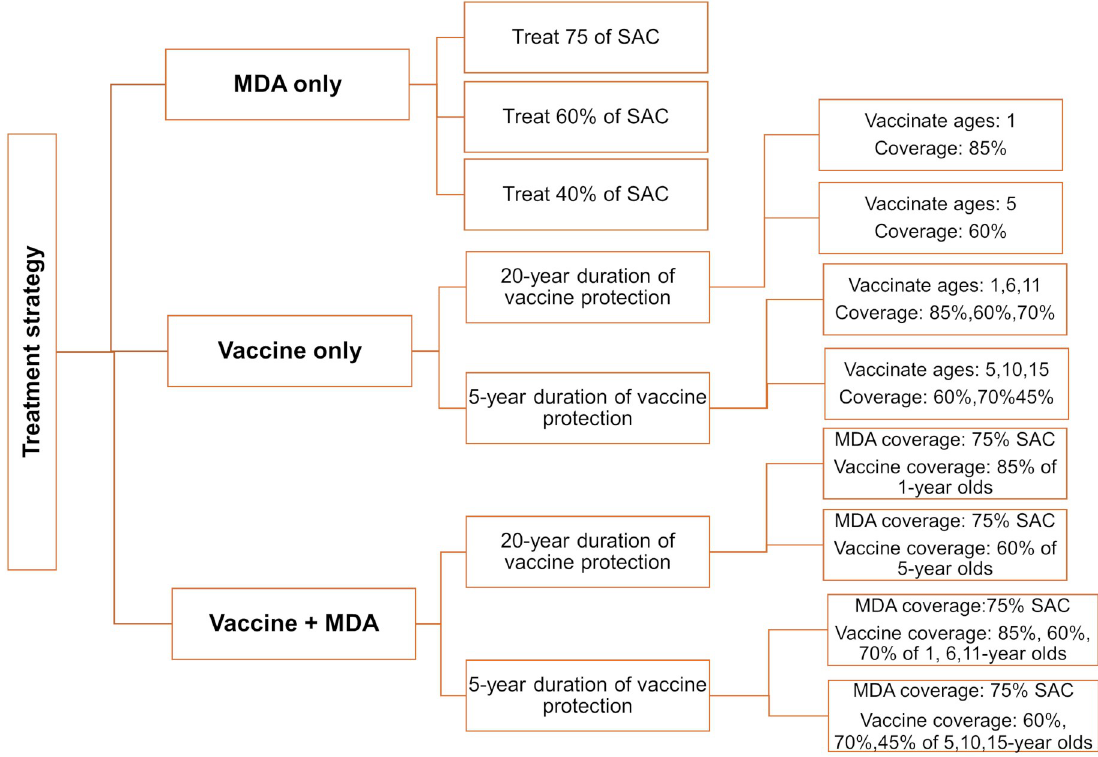
Fig 1. Coverage levels for the infected population. Treatment strategies examined in the simulations for different transmission settings.